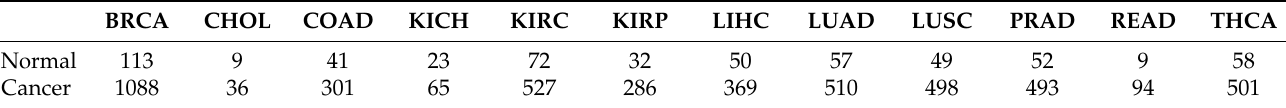
Table 4. Sample distributions of 12 cancers considered in this experiment.